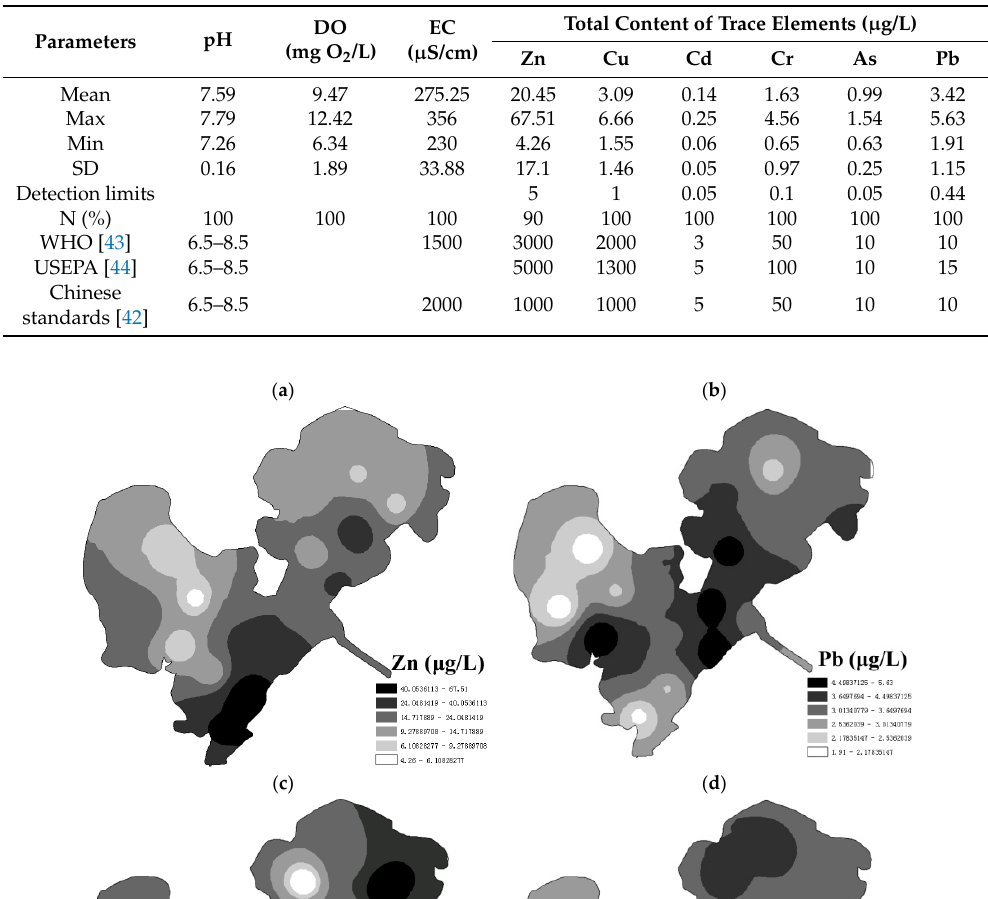
Table 3. Summary statistics of basic indexes and total content of trace elements in surface water samples ( N = 20) from Honghu Lake.